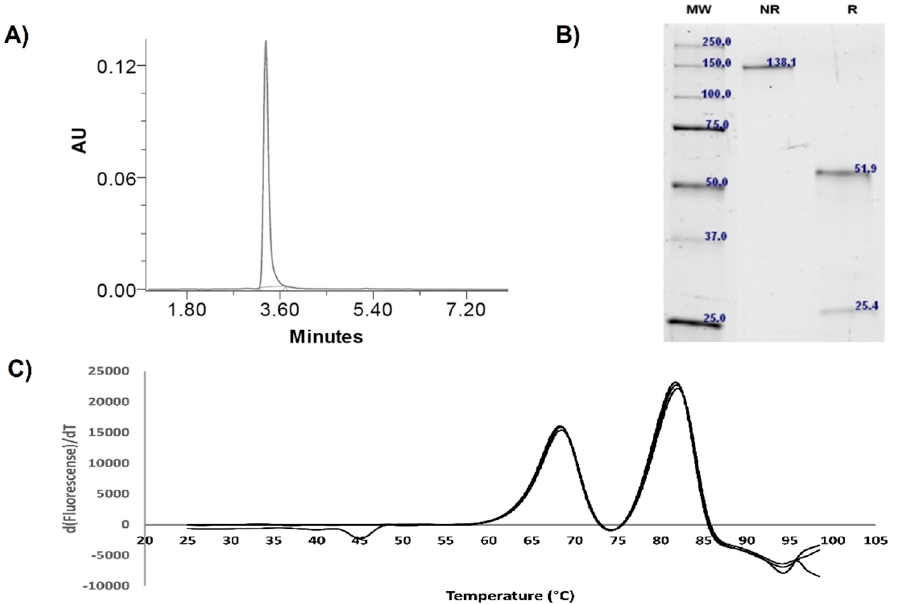
Figure 1. Physicochemical characterization of IgG-A7. ( A ) Analytical SEC shows close to 100% monomeric content. ( B ) SDS-PAGE under non-reducing conditions indicates a single band at 138 kDa and two bands: 51.9 kDa (heavy chain) and 25.4 kDa (light chain) under reducing conditions showing. ( C ) Protein Thermal Shift™ assay shows two unfolding transitions: 68.5 °C and 82.1 °C.